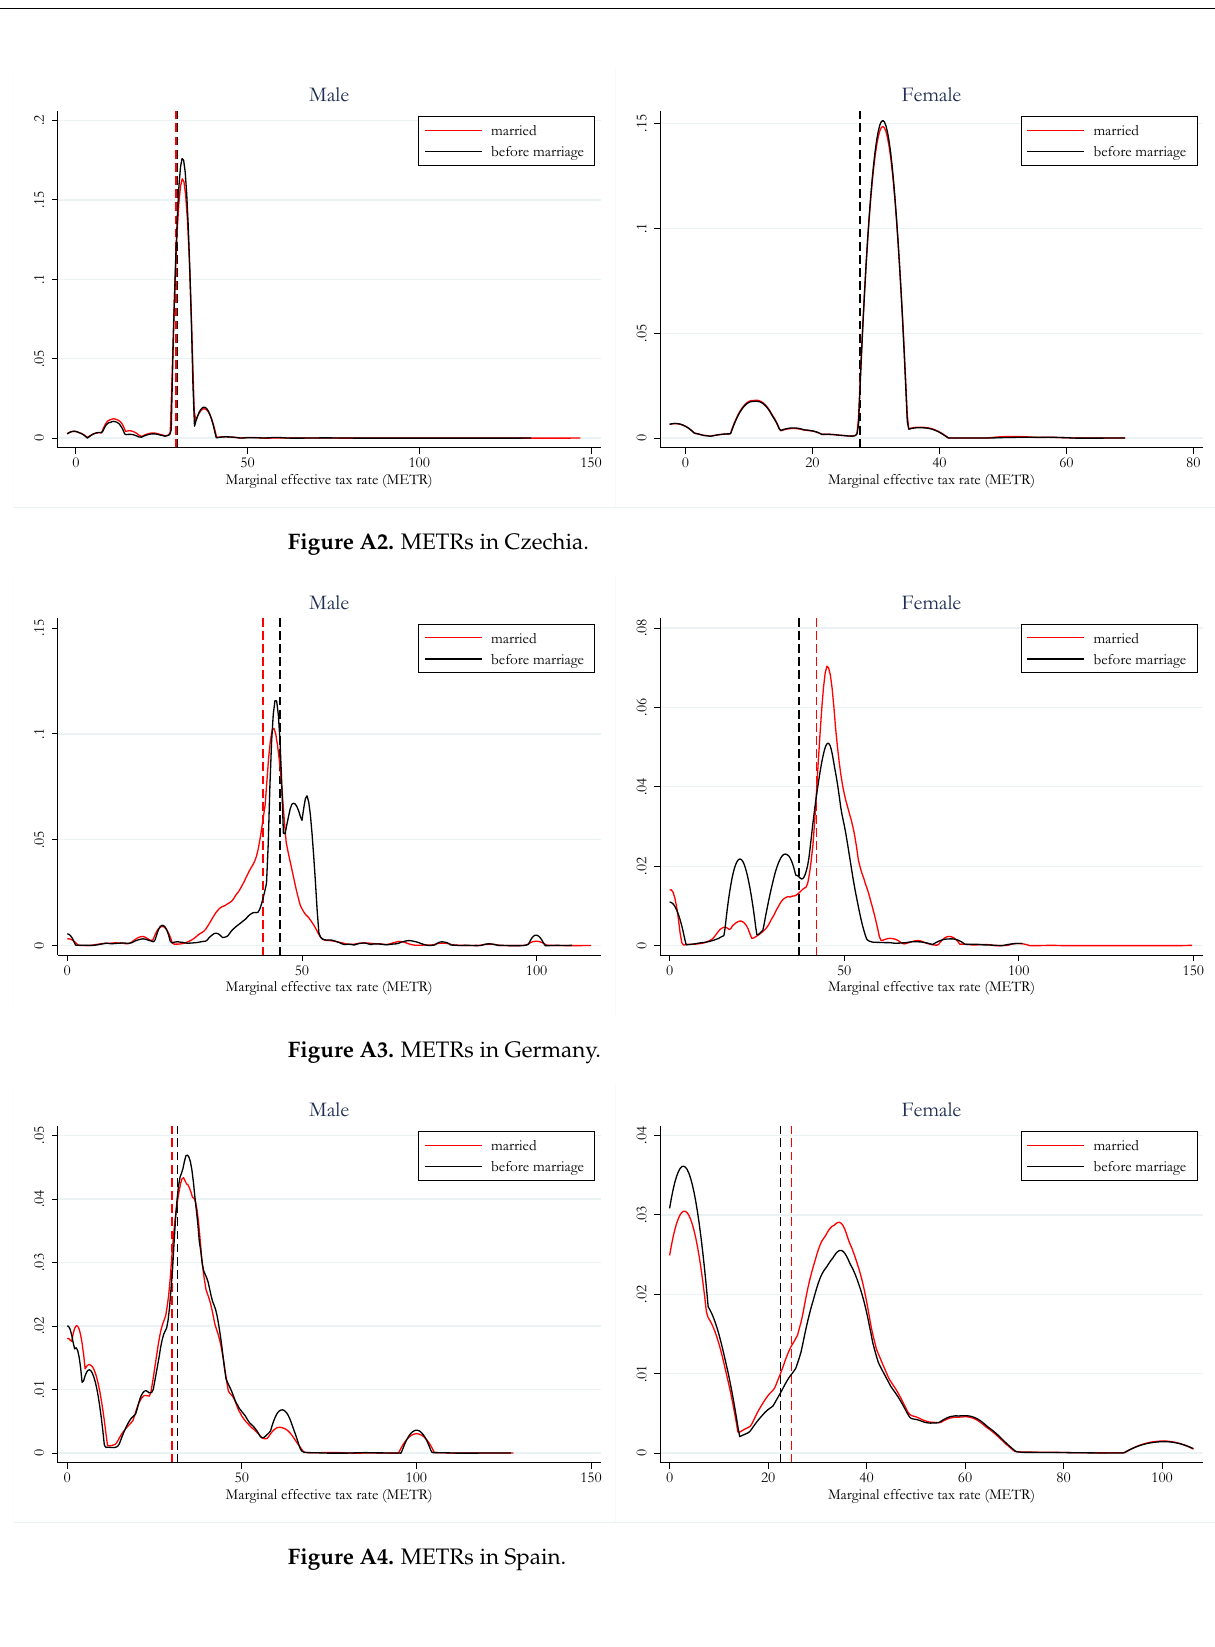
Figure A4. METRs in